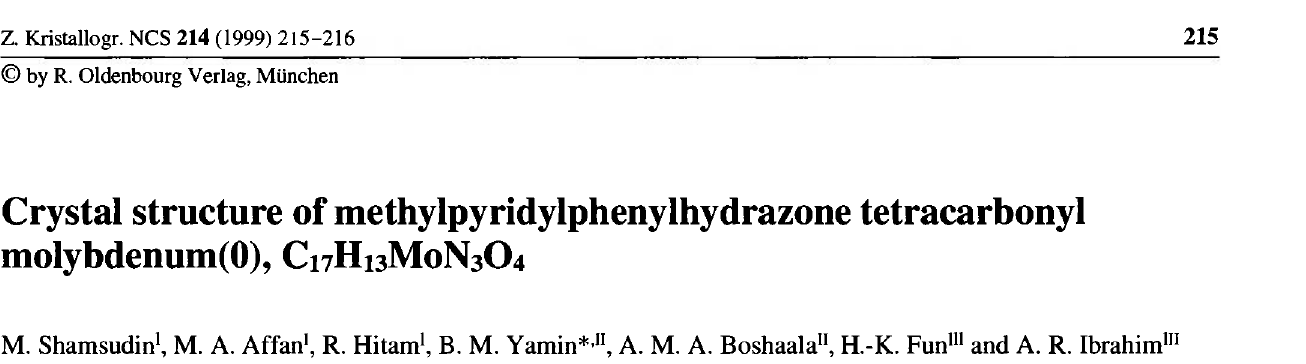
Table 2. Atomic coordinates and displacement parameters (in A 2